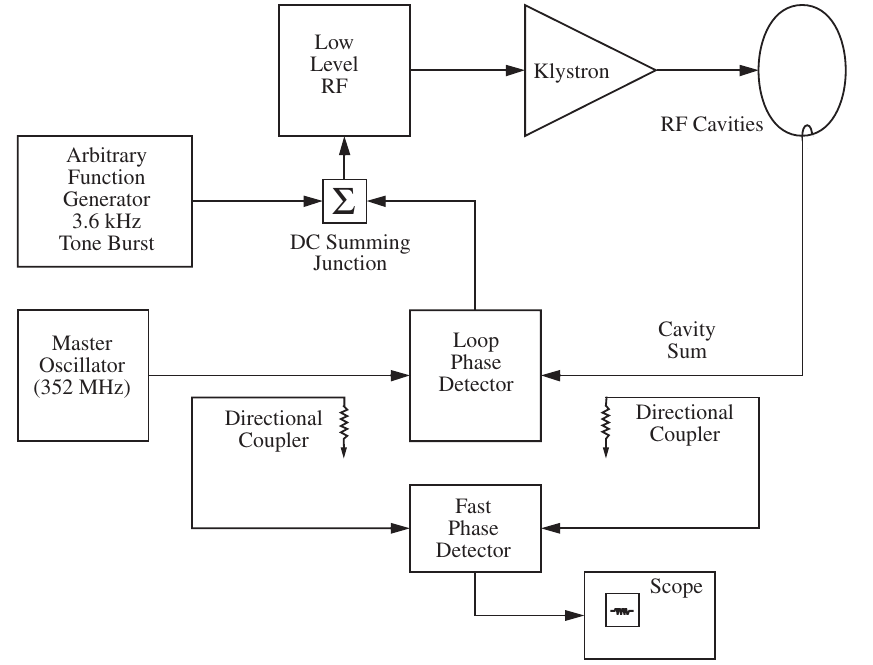
FIG. 12. rf phase control loop with phase modulation and additional